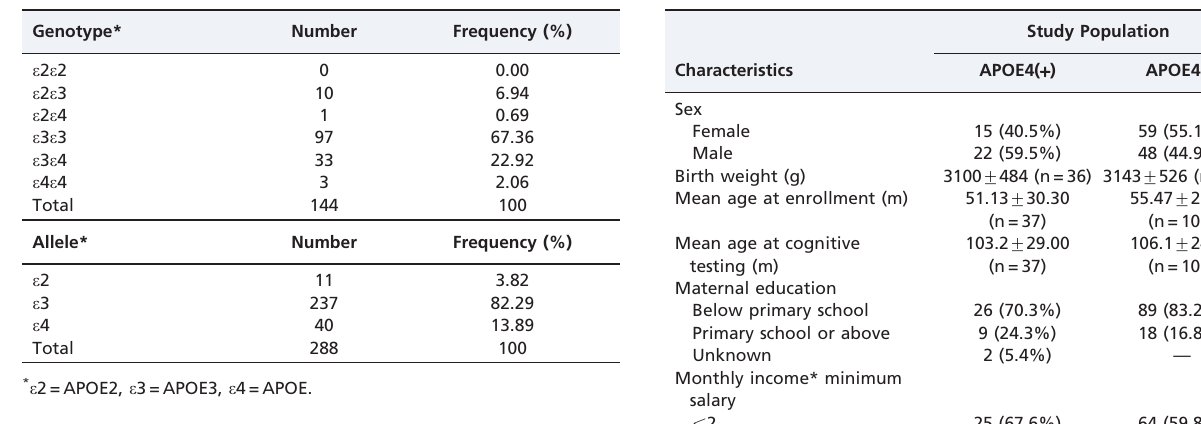
Table 2 - Demographic and anthropometric data for the Parque Universita´rio study population at baseline segregated by APOE4 allele status.